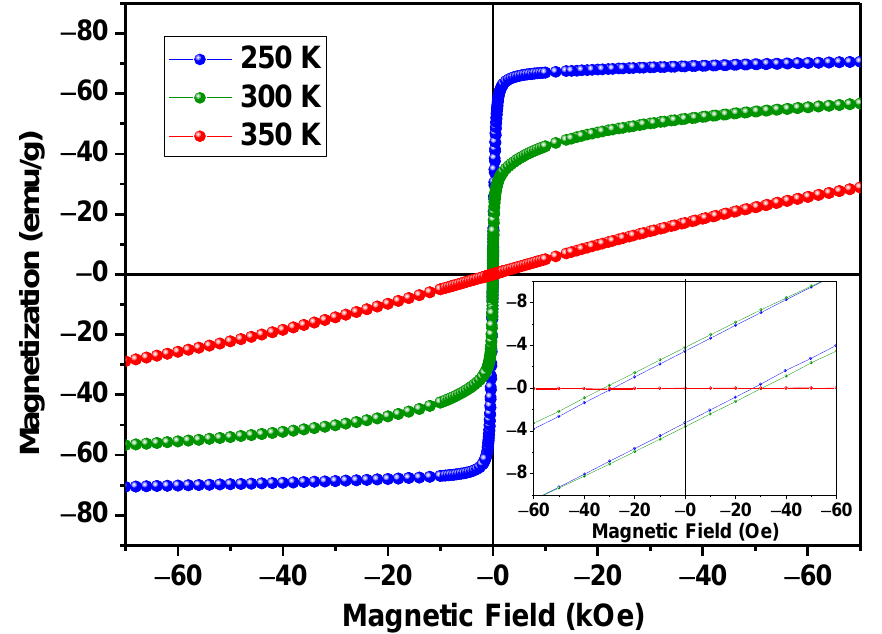
Table 3. Magnetic parameters of LSM particles (accuracy 10 −8 emu).